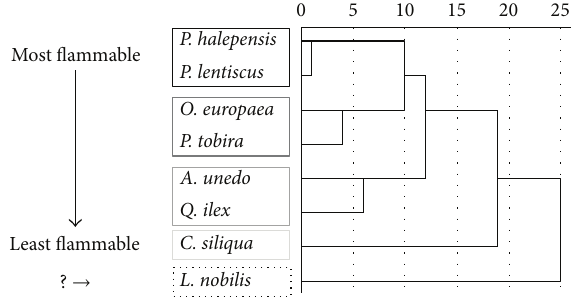
Figure 3: Hierarchical cluster analysis based on standardized mea- sured flammability parameters: ignition delay (ID), ignition temper- ature (IT), flame extinguish time (FET), and maximal temperature (MT). Distances presented in the dendrogram are automatically rescaled by the SPSS software and thus the presented scale does not show the calculated